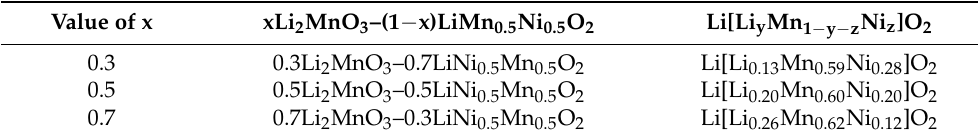
Table 1. Stoichiometry of Li-rich layered oxides in the most common formulations. Value of x